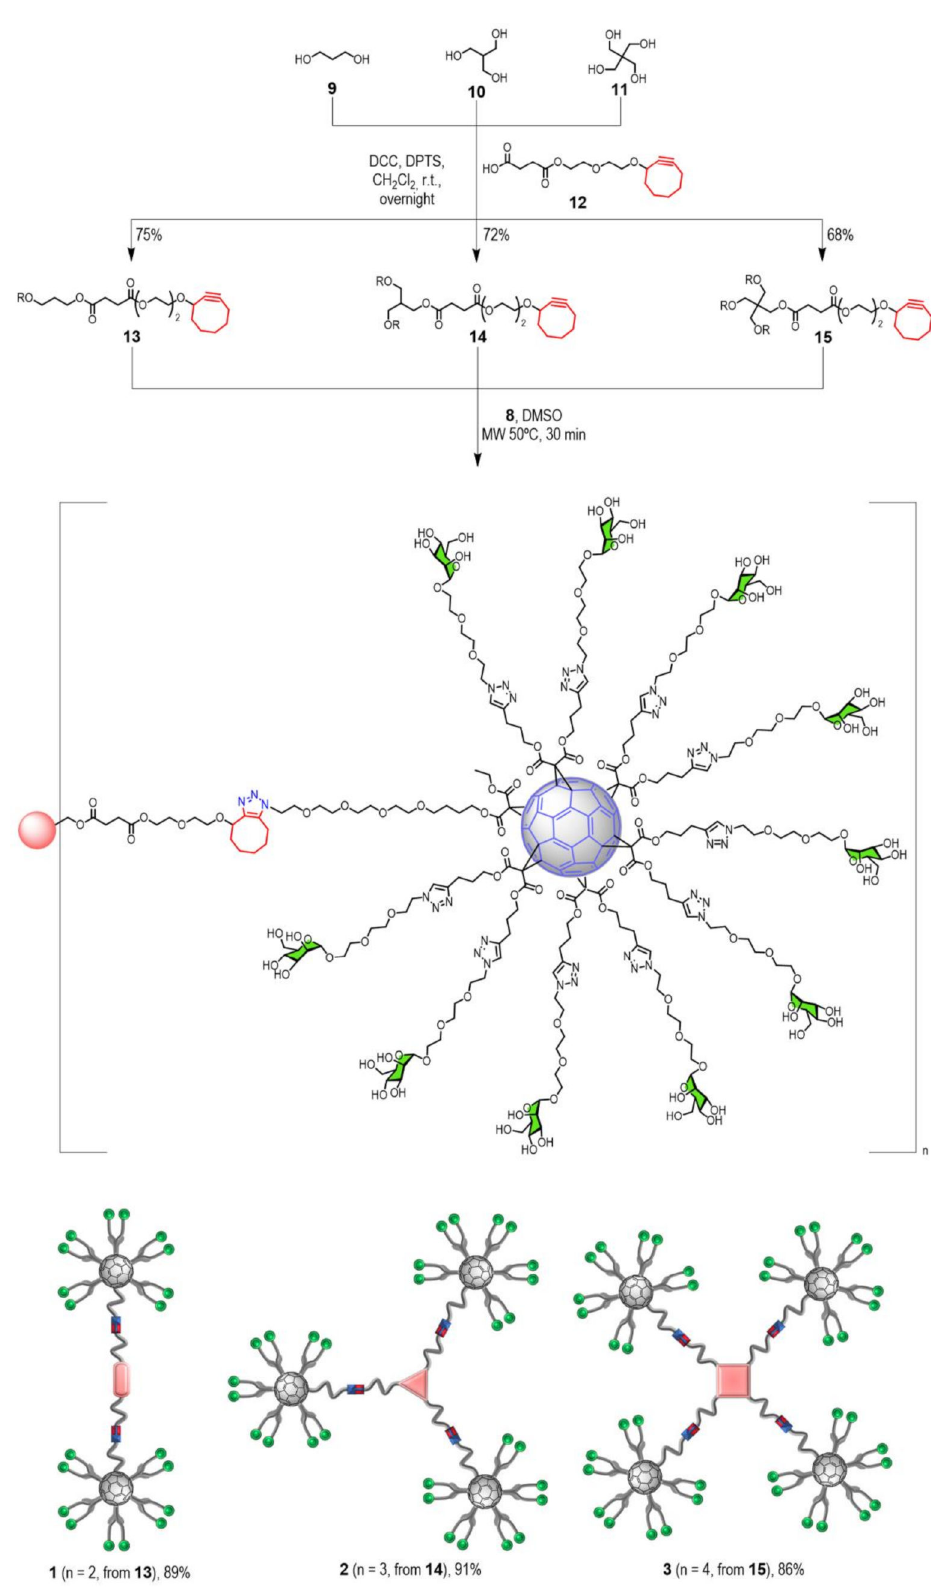
Scheme 2. General synthetic procedure for the preparation of the central core structures 13 – 15 and subsequent SPAAC reaction for the preparation of oligomers 1 – 3